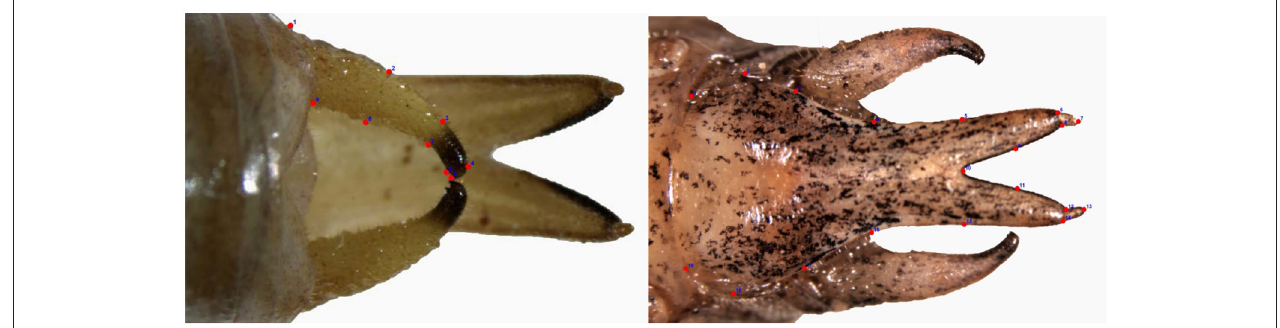
FIGURE 1 | (A) Cerci. (B) Sub-genital plate. Approximate locations of landmarks denoting the boundary of the right cercus (A) and the sub-genital plate (B) used in landmark-based geometric